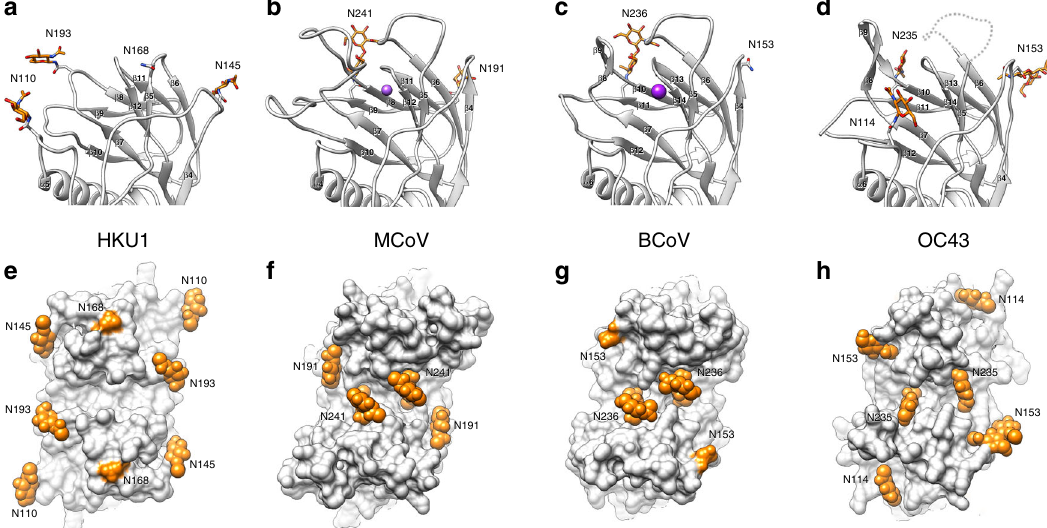
Fig. 4 Comparison of HKU1 HE lectin domain glycosylation to related embecoviruses. a Ribbon representation of the monomeric HE of HKU1, b MCoV- NJ, c BCoV and d OC43 lectin domain, with an approximation of the unmodelled β 5- β 6 loop shown as a dashed line. Each lectin domain glycosylation site is labelled and colour-coded according to their conservation across the four HEs shown. Modelled N -linked glycans are shown as sticks and coloured orange. e Top down view of the dimeric HE of HKU1 HE, f MCoV-NJ (PDB ID: 5JIL), g BCoV (PDB ID: 3CL5) and h OC43 (PDB ID: 5N11) lectin domain, shown as a surface representation. Modelled N -linked glycans, shown as spheres, and unmodelled N -glycosylation sites, are coloured orange and labelled as shown in ( a – d ).